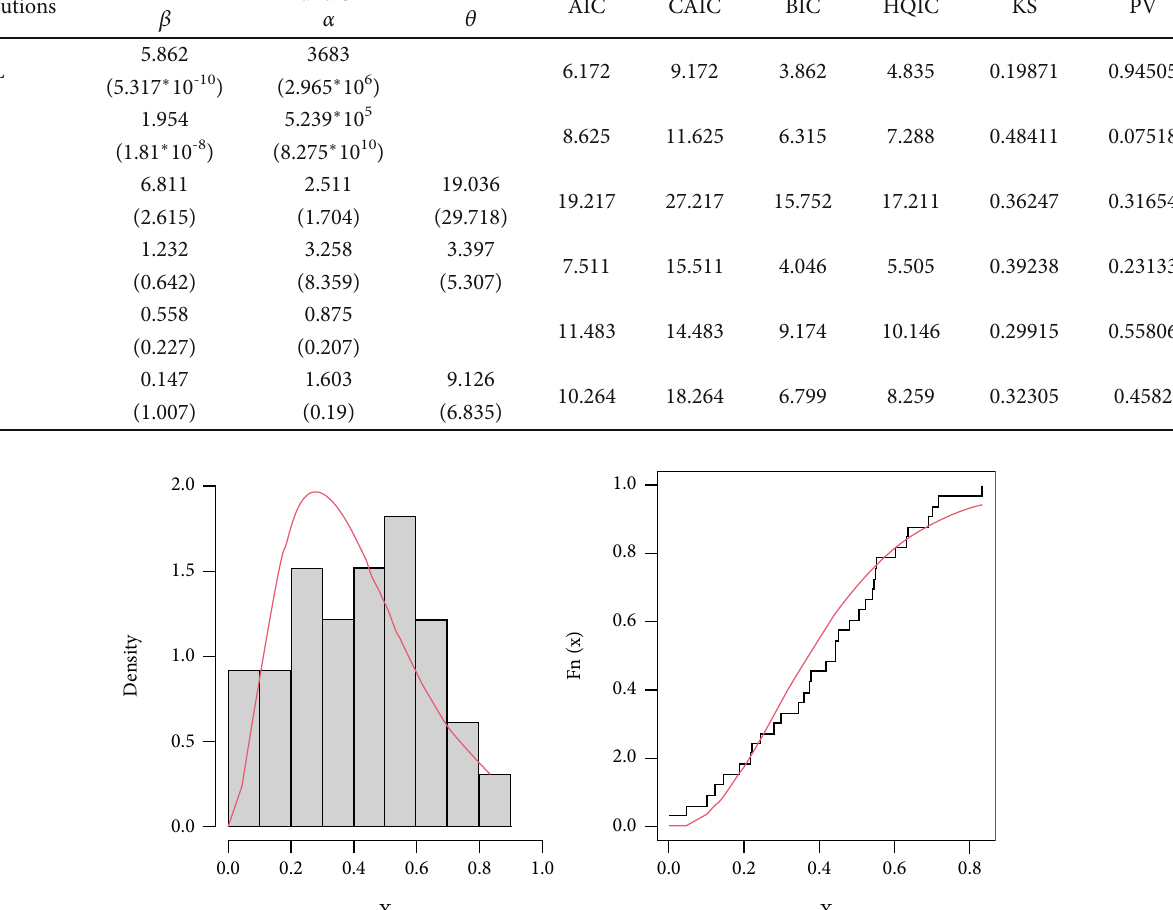
Figure 7: Estimated pdf and cdf of competitive model for the fi rst data